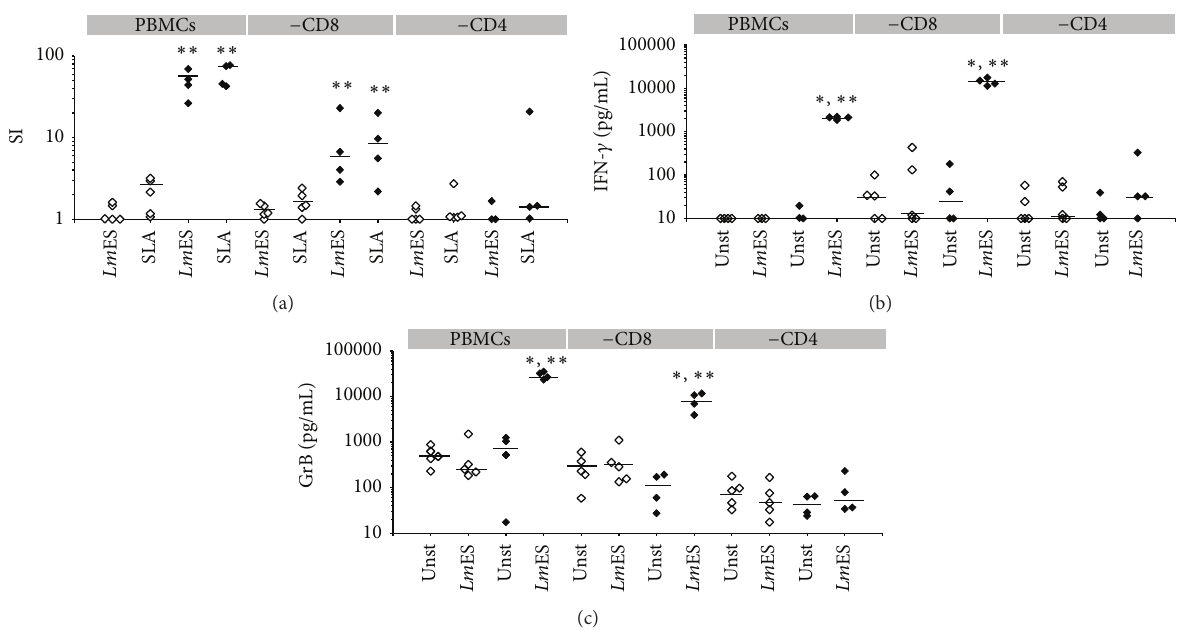
Figure 2: Immune response induced by Lm ES in total PBMCs or PBMCs depleted of CD4 + or CD8 + T cells. Whole PBMCs or those depleted of CD4 + (-CD4) or CD8 + T cells (-CD8) from 4 HZCL ( ⧫ ) and 5 HC ( ◊ ) were stimulated with Lm ES (10 𝜇 g/mL) for 5 days. (a) Proliferative responses were assessed by [ 3 H]-thymidine uptake. IFN- 𝛾 (b) and GrB (c) secretion was evaluated in supernatants of cultures at day 5 using ELISA tests. Bars represent median values. Statistical analysis: ∗ 𝑃 < 0.05 , when comparing the stimulated cells to the unstimulated cells, (Unst) and ∗∗ 𝑃 < 0.05 , when comparing HZCL to